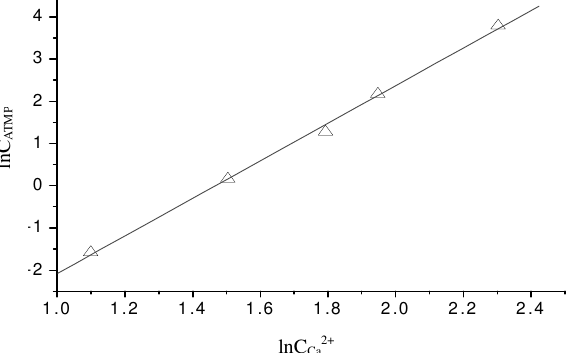
Figure 5. The plot of natural logarithms of C and